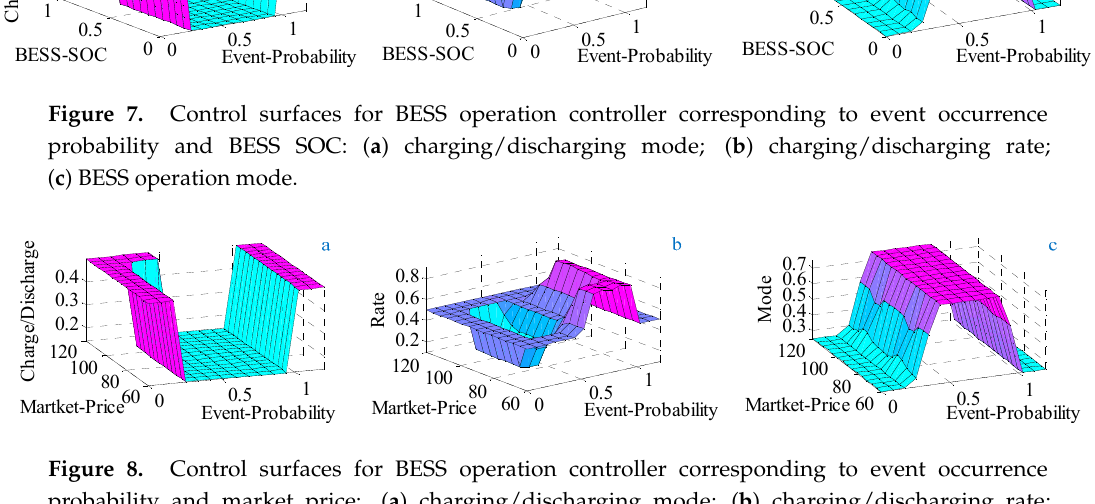
Figure 8. Control surfaces for BESS operation controller corresponding to event occurrence probability and market price: ( a ) charging/discharging mode; ( b ) charging/discharging rate; ( c ) BESS operation mode.